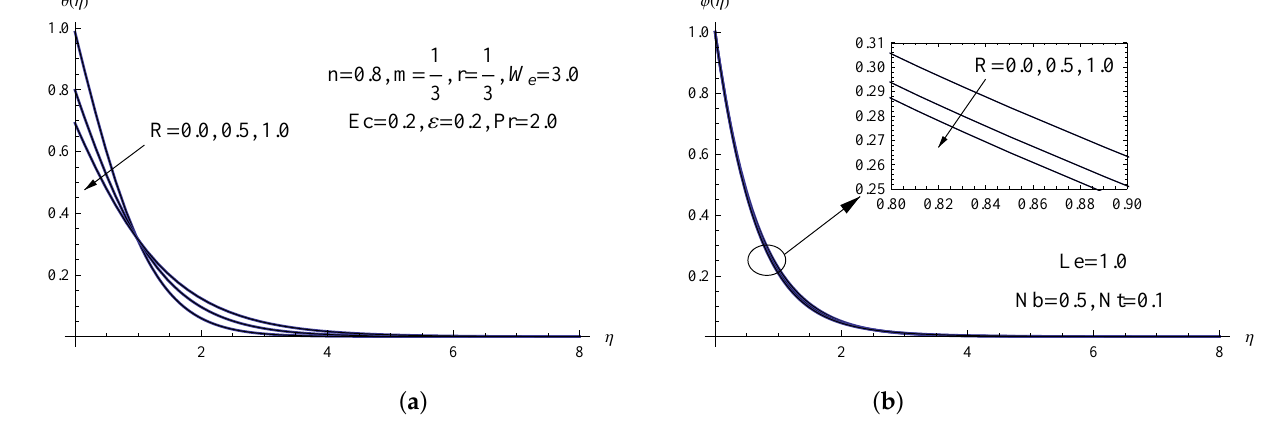
Figure 4. ( a ) θ ( η ) via R ; ( b ) φ ( η ) via R . Figure 5 displays a temperature θ ( η ) and concentration φ ( η ) impact graph for various values of the thermal conductivity parameter ε . When the thermal conductivity parameter’s values increase, the nanofluid temperature distribution slows down, particularly close to the sheet, while the opposite scenario occurs away from the sheet, thickening the thermal boundary layer. In light of this, systems, especially those with variable heat flux, may choose to use the thermal conductivity parameter as a coolant parameter. The concentration field is indirectly impacted by the thermal conductivity parameter, thus as it grows, the concentration of nanoparticles somewhat